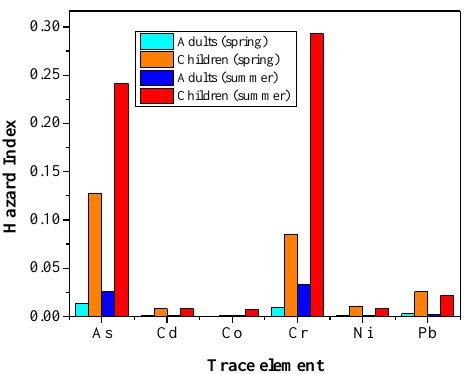
Figure 5. Hazard index (HI) values of selected heavy metals for non-carcinogenic health risk in Asaluyeh for adults and children.